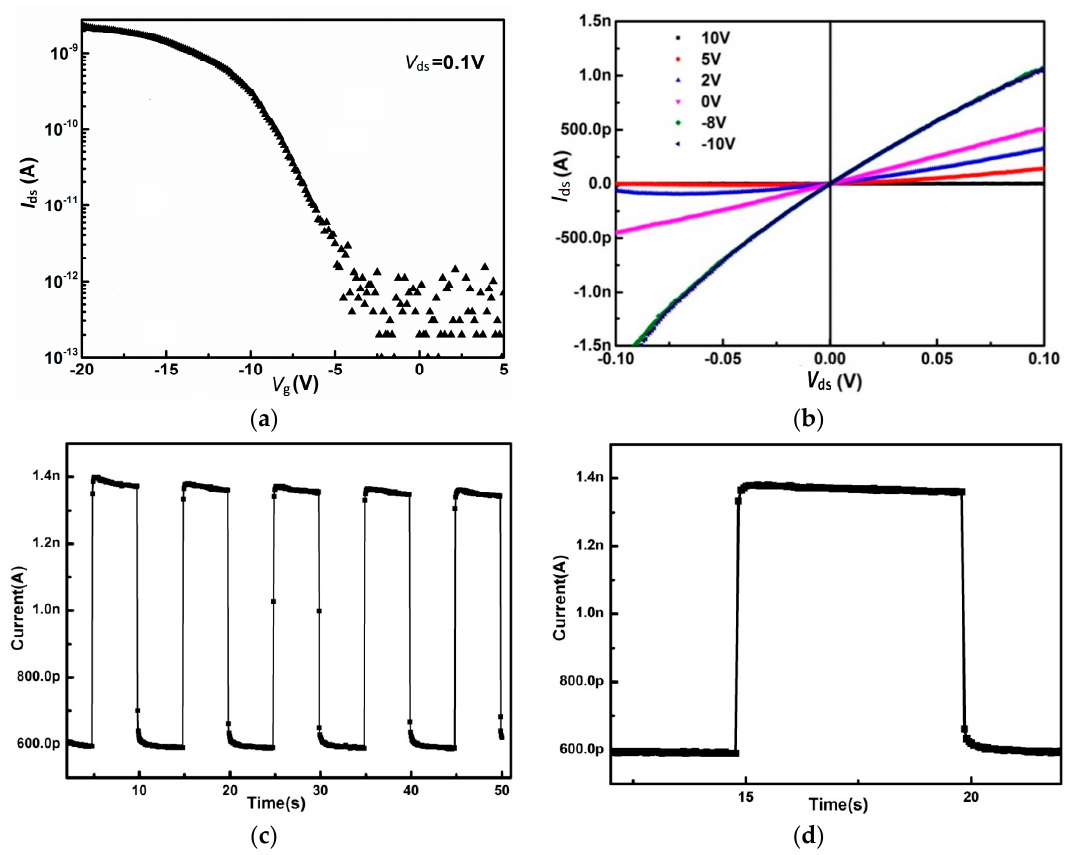
Figure 6. ( a ) FET transfer characteristics; ( b ) output characteristics; ( c ) photo-response under V ds = − 10 V; and ( d ) time resolved photoresponse in a single period.